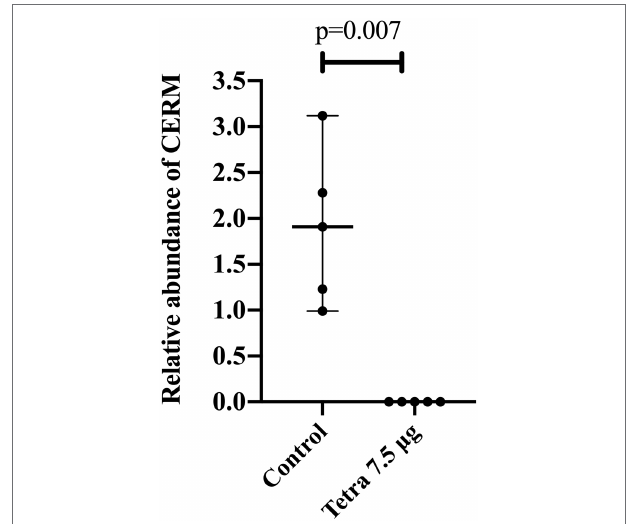
FIGURE 1 | Relative abundance of CERM ( Coxiella endosymbiont from Rhipicephalus microplus ) analyzed by qPCR in metanymphs from control and tetracycline-treated groups collected from the host on the 14th post- infestation day. Each dot represents an individual whole metanymph. The levels of CERM were expressed as the median with 95% of CI of five biological samples with three technical replicates in each point. Statistical analyses: Mann–Whitney